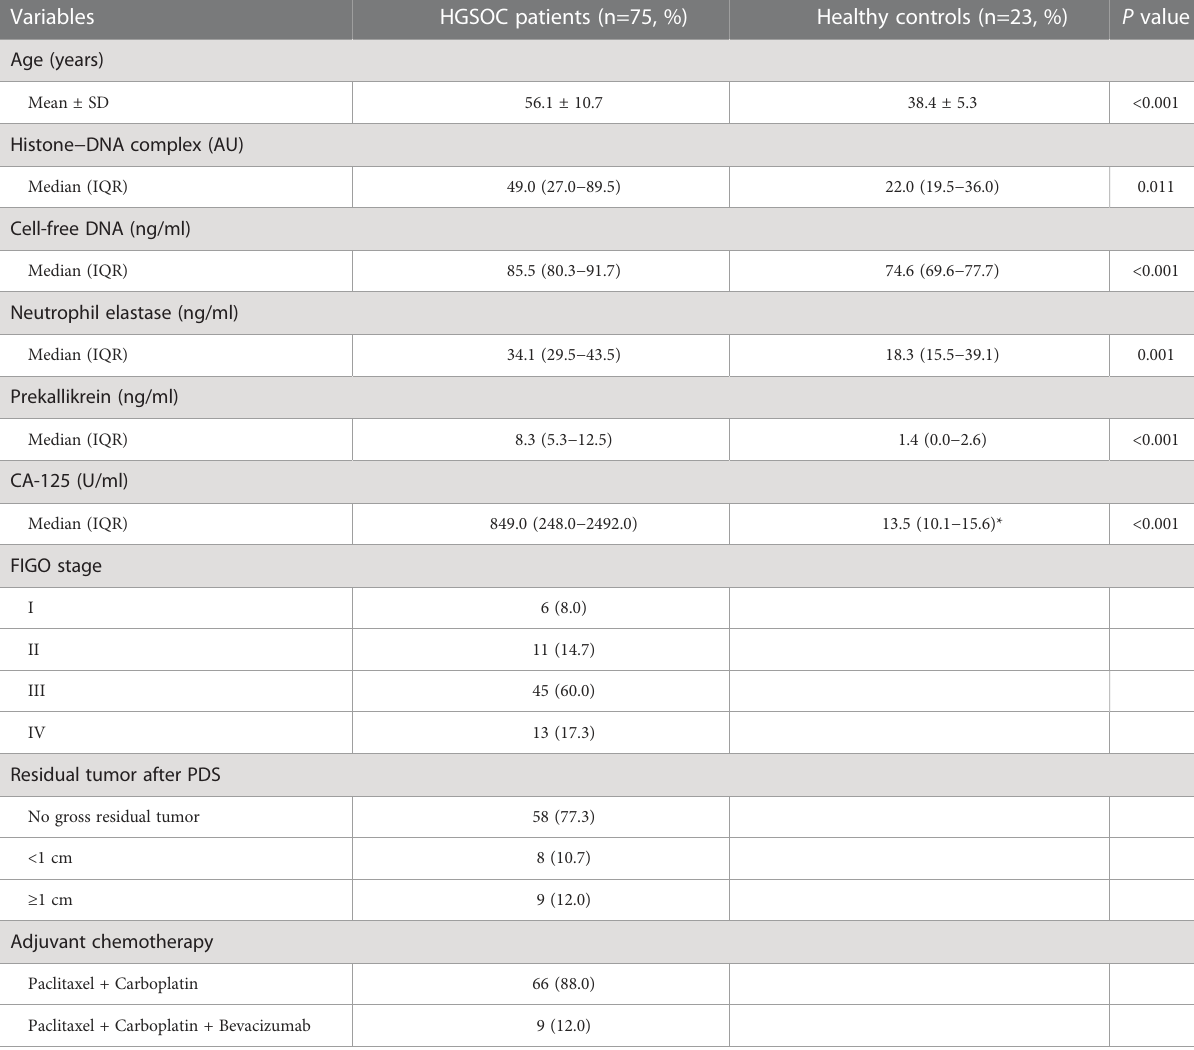
AU,arbitraryunit;FIGO,InternationalFederationofGynecologyandObstetrics;HGSOC,high-gradeserousovariancancer,IQR,interquartilerange;PDS,primarydebulkingsurgery; SD, standard deviation. Missing data: